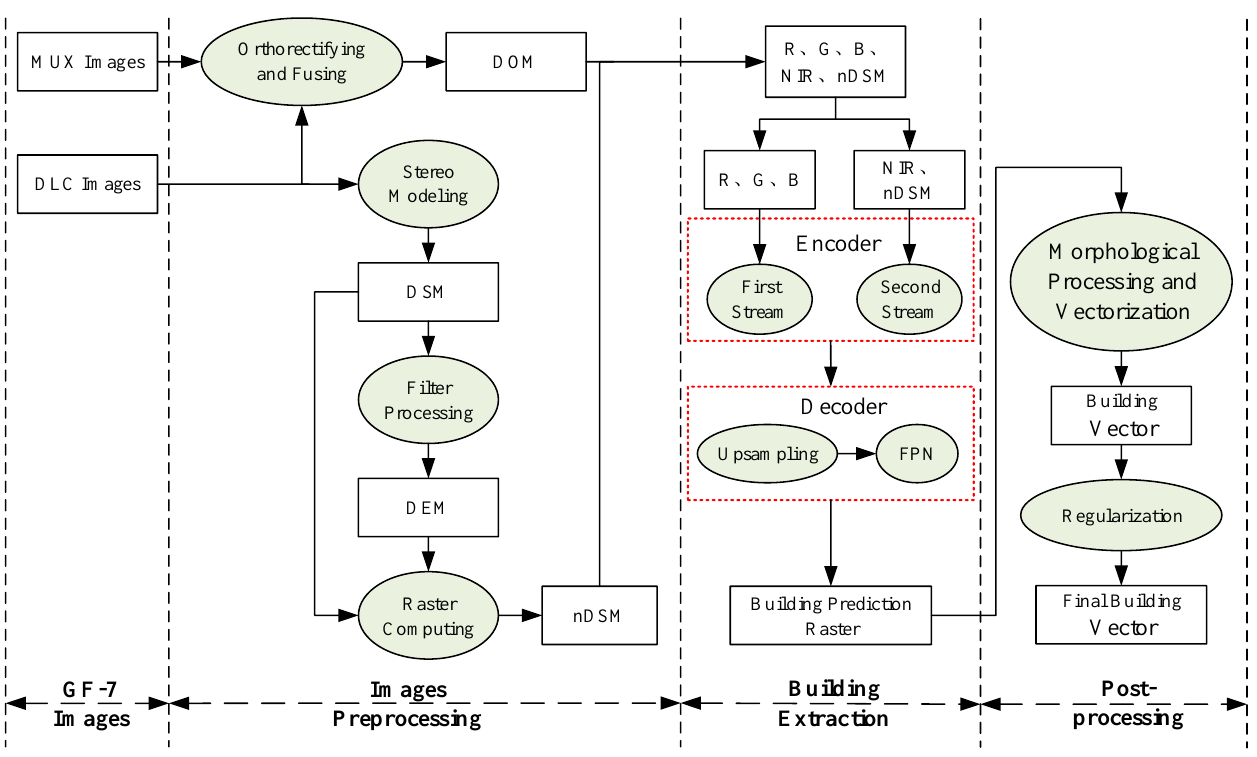
Figure 2. The flowchart of the proposed DMU-Net building extraction method.